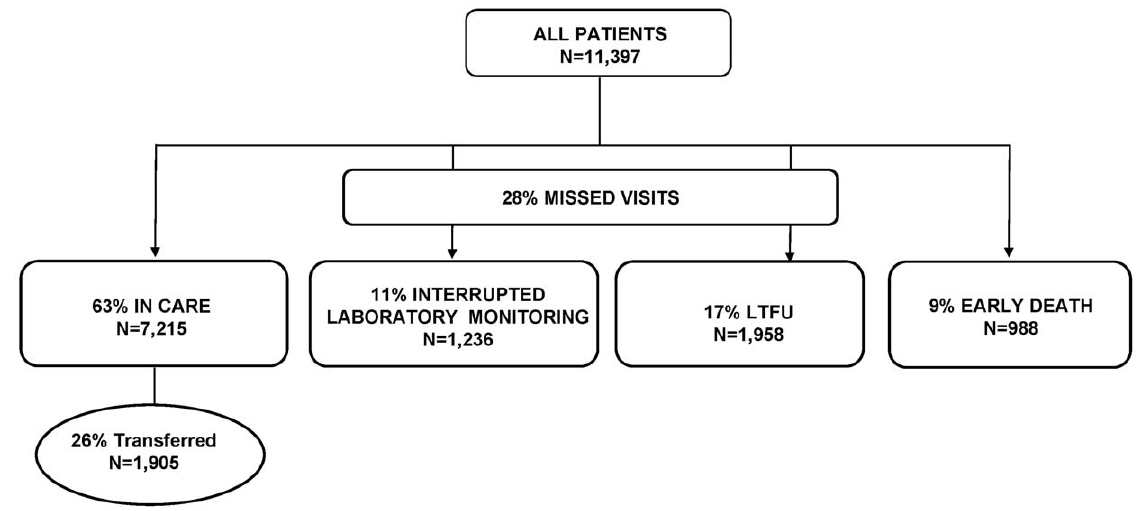
Figure 1. Summary of patient outcomes in a cohort study of LTFU in a large South African ART program.